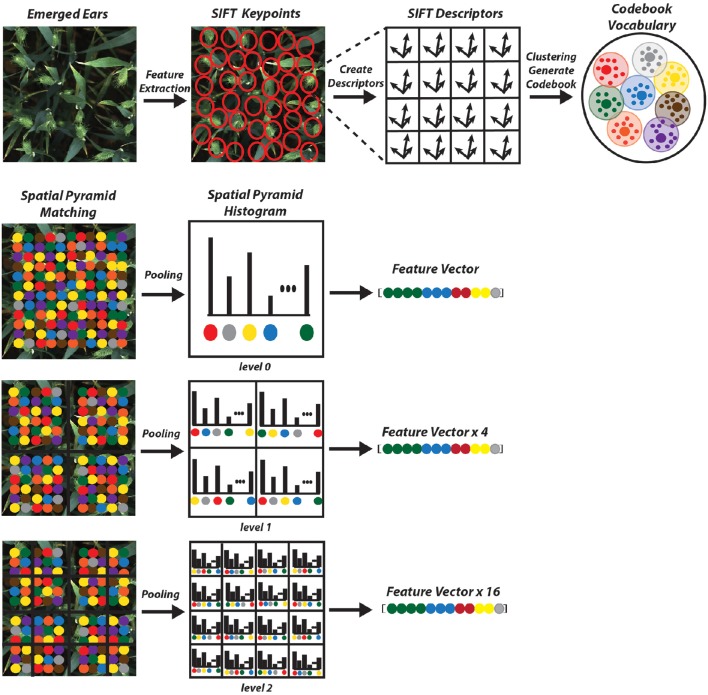
Schematic representation of the proposed method.